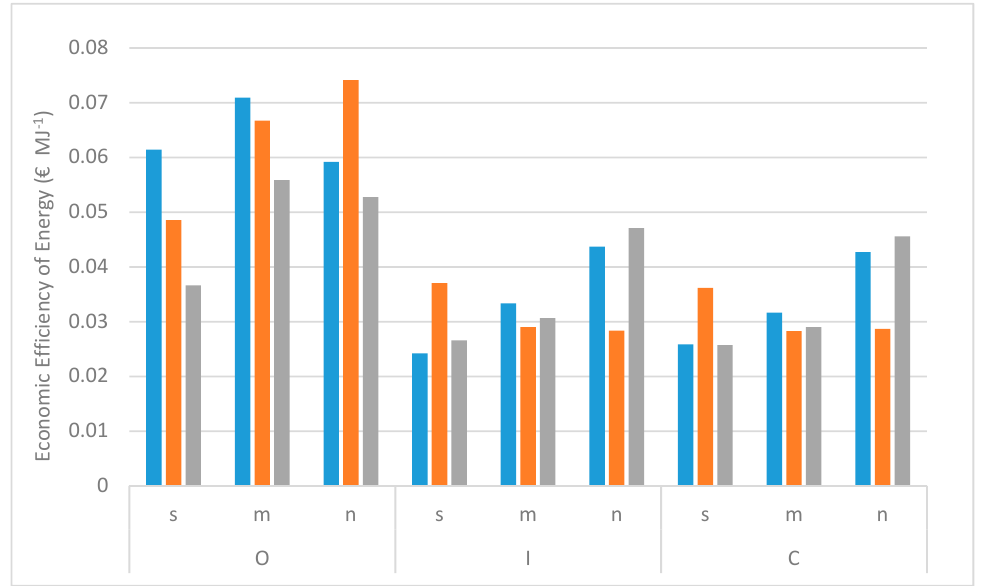
Figure 7. Results of “Economic Efficiency of Energy” indicator per scenario.